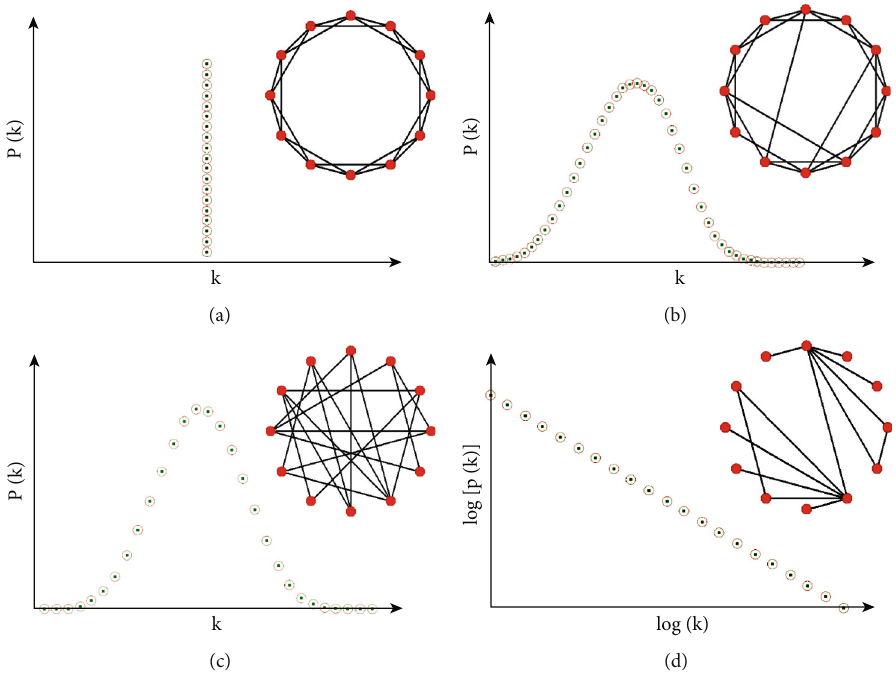
Figure 1: Network model structure: (a) the regular network [28], (b) ER random network [29], (c) WS small-world network [30], and (d) BA scale-free network [31].